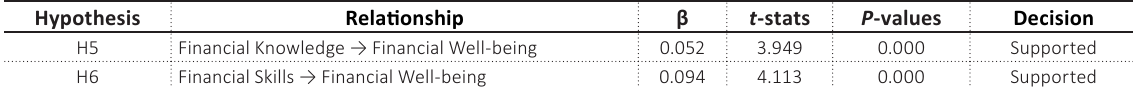
Table 6. Results of the indirect